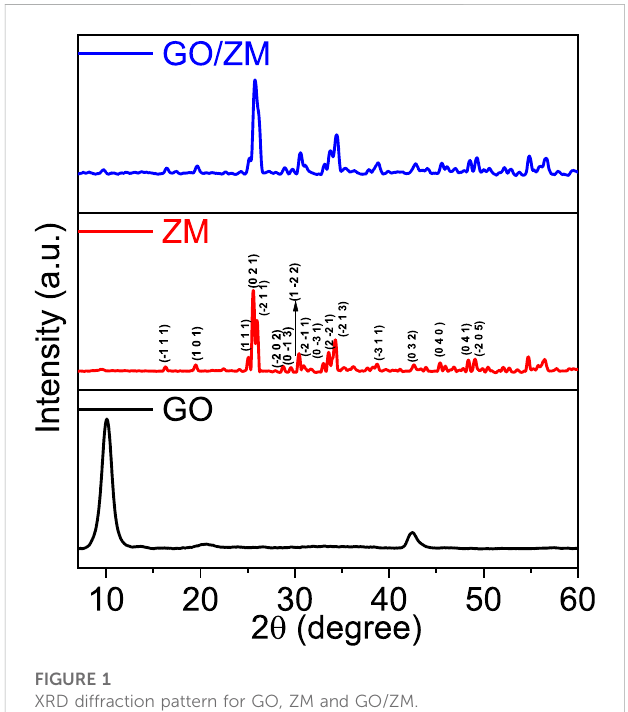
FIGURE 1 XRD diffraction pattern for GO, ZM and